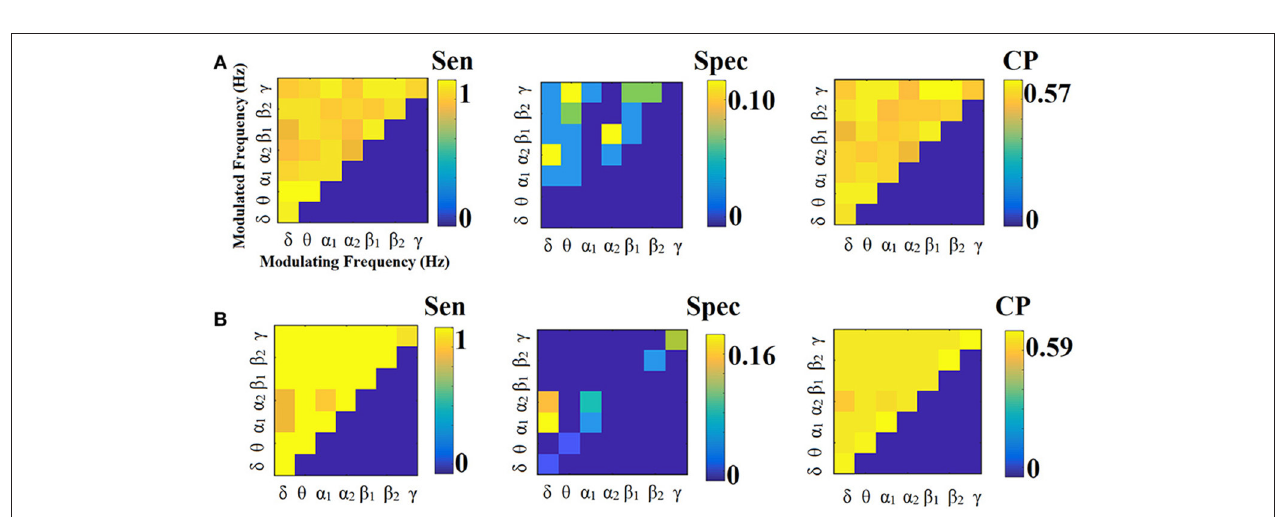
FIGURE 11 | Sensitivity, specificity and classification performance of iPLV using PCA ROI representation and tensorial treatment of each SL-FCG. (A) Sensitivity, specificity and classification performance for the LOOCV. (B) Sensitivity, specificity and classification performance for the 5-fold CV. Sen, sensitivity; Spec, specificity; CP, classification